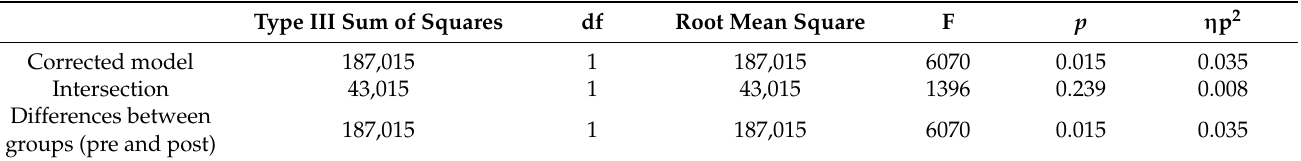
Table 5. Comparison of inter-subject effects for the variable